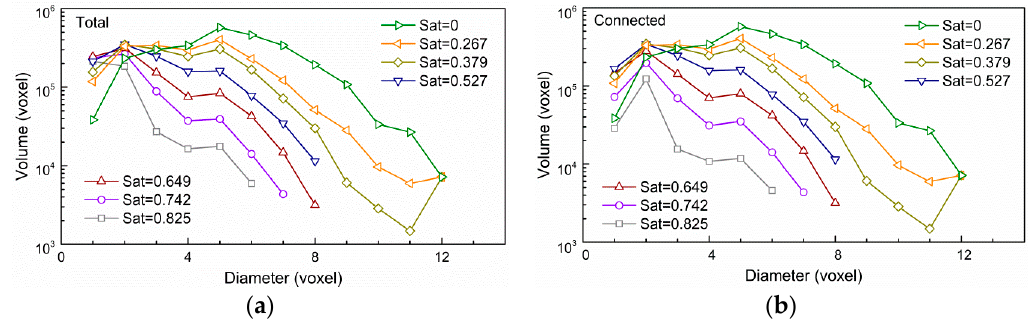
Figure 4. Volume of pores for different diameters under various saturations: ( a ) Total pores. ( b ) Connected pores.